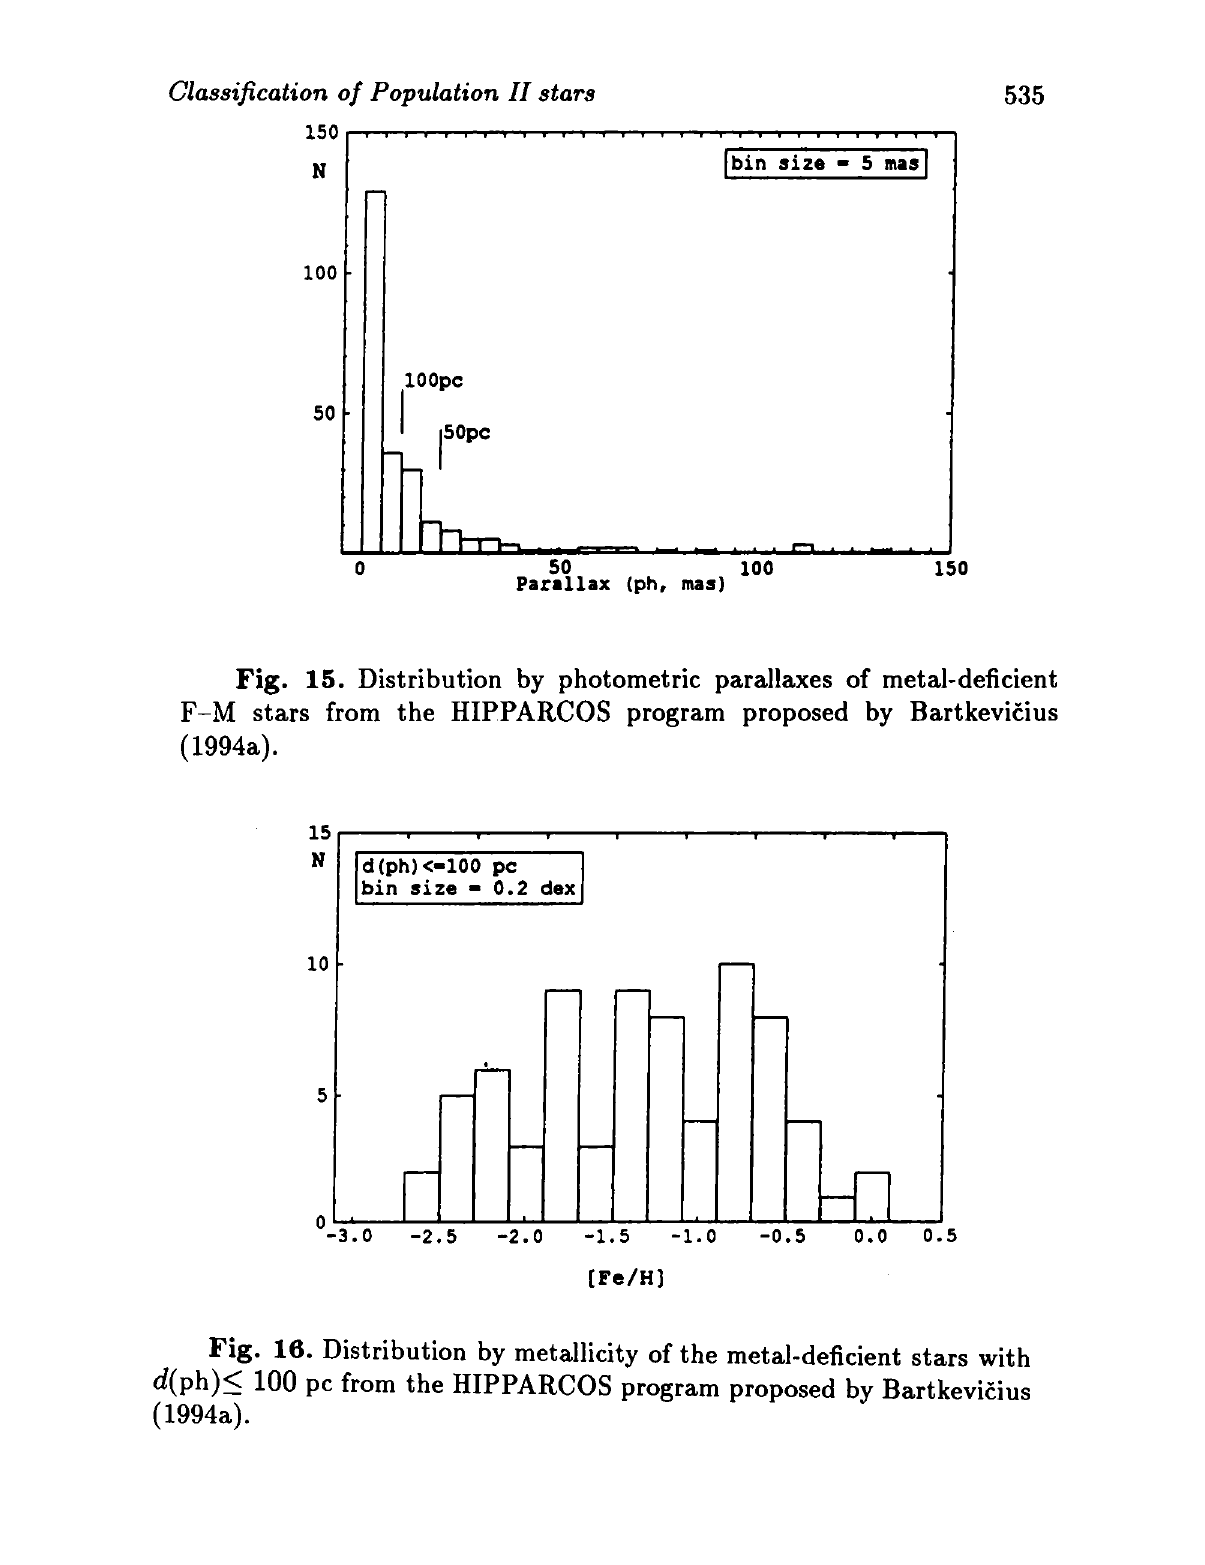
Fig. 16. Distribution by metallicity of the metal-deficient stars with d(ph)< 100 pc from the HIPPARCOS program proposed by Bartkevicius